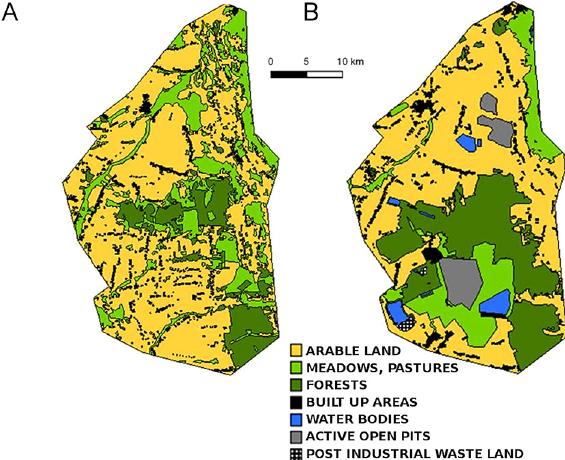
Fig. 2. Types of land use in the Adamów-Koźmin